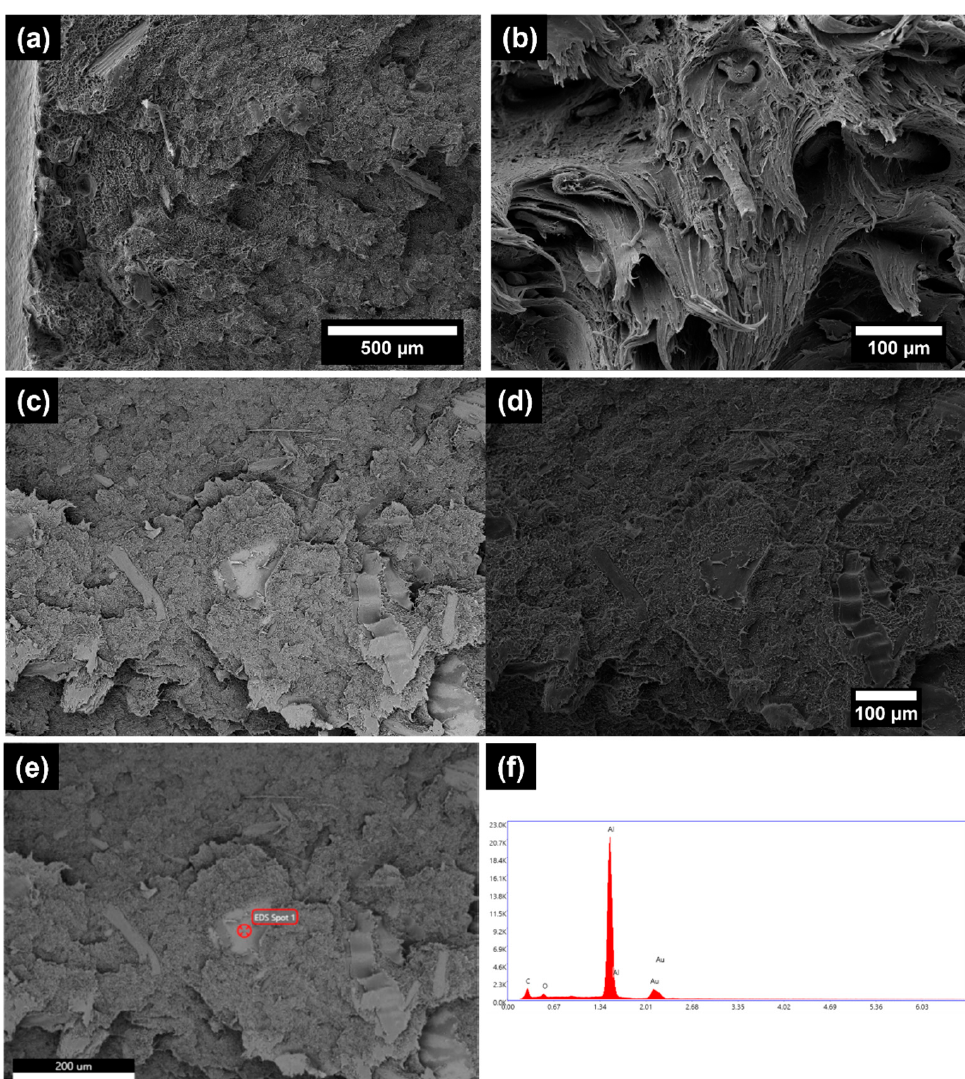
Figure 4. SEM micrographs of unfilled EcoAllene: ( a , b ) after Charpy impact test; ( c , d ) after tensile test. ( c ) shows the backscattered signal, while ( d ) the secondary signal; ( e ) after tensile test in backscattered signal and ( f ) EDS (Energy Dispersive X-ray Spectroscopy) spectrum.